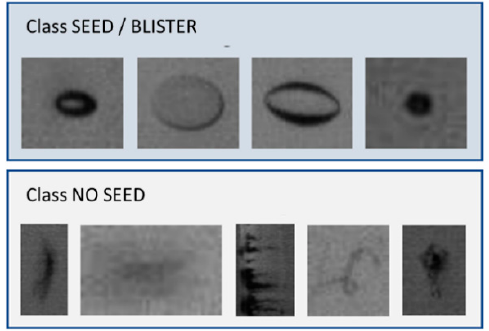
Figure 7. Examples of images of both classes existing in the dataset.